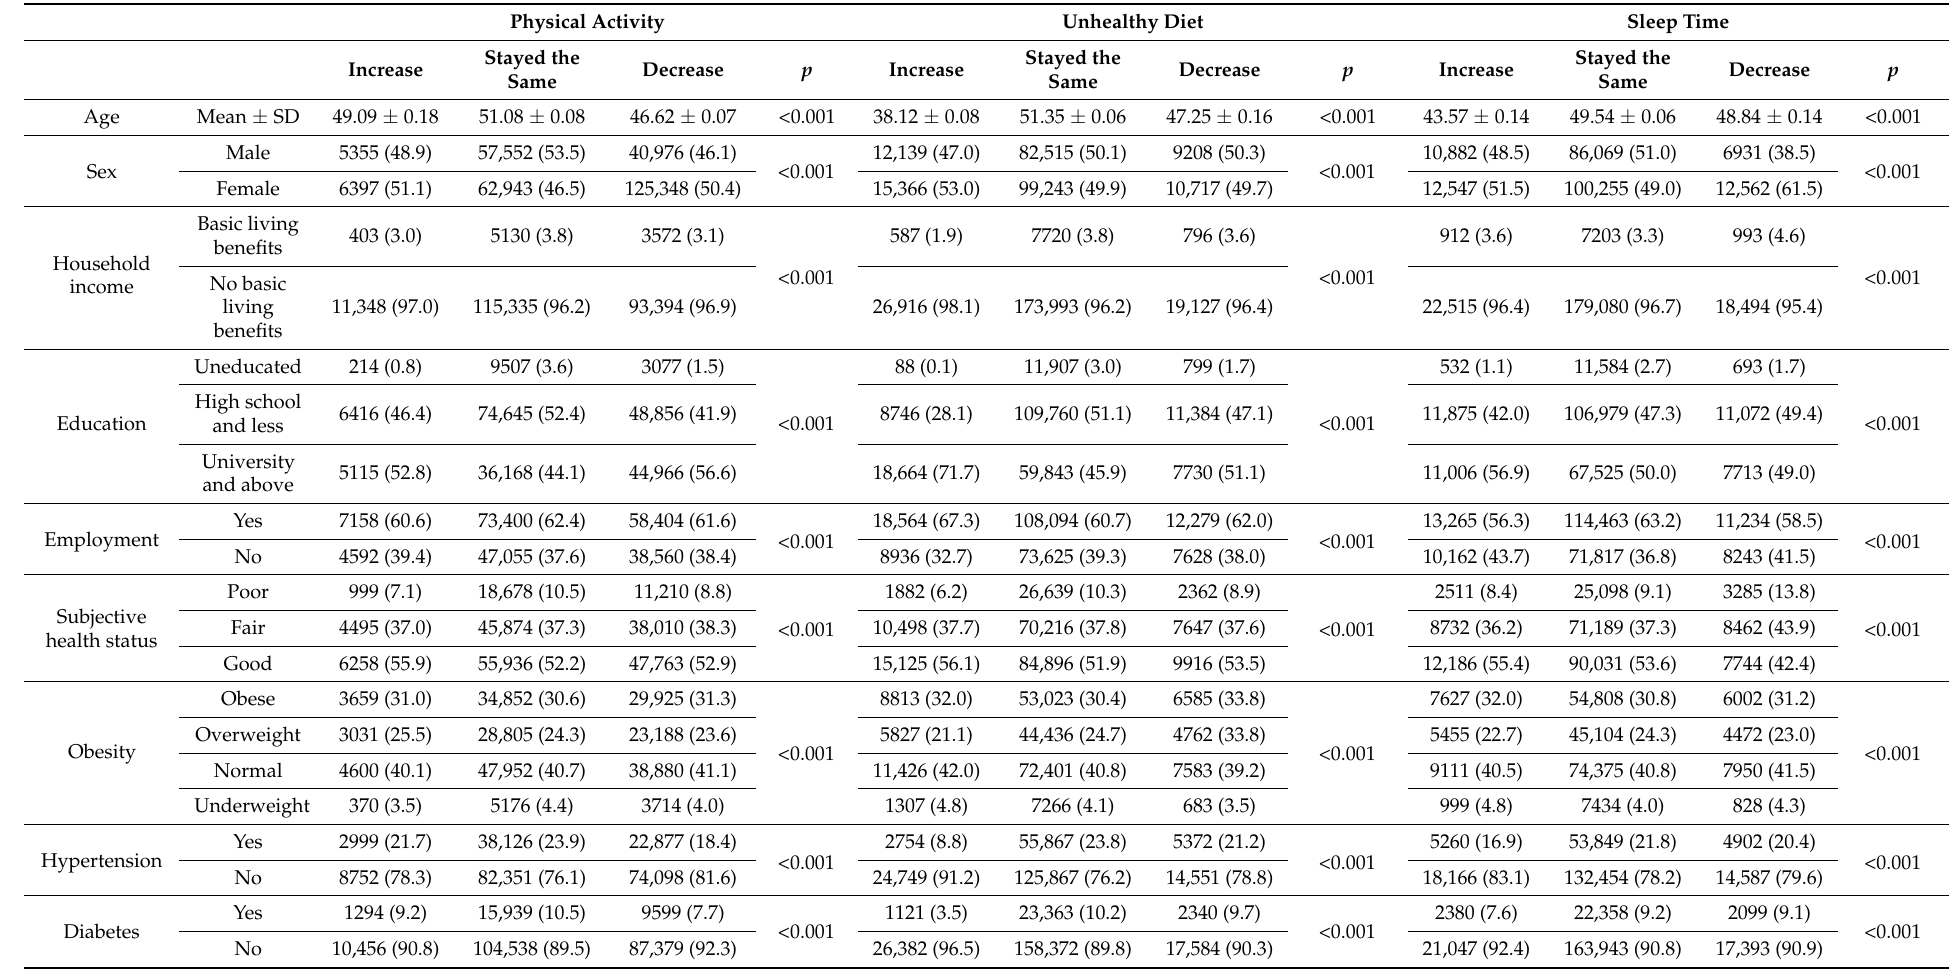
Table 3. Relationships of participant characteristics with changes in health behaviors during the COVID-19